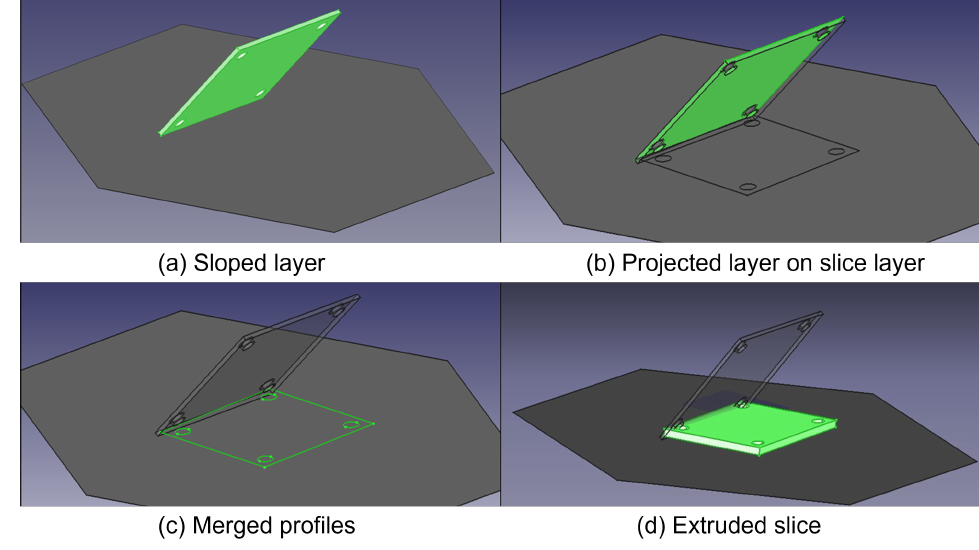
Figure 10. Procedure of squashing operation on single slice: ( a ) select a shape to be squashed in the slice layer, ( b ) project all edges of a shape on the slice layer, ( c ) merge the edges and time the internal handing edges, and ( d ) extrude merged edges into a